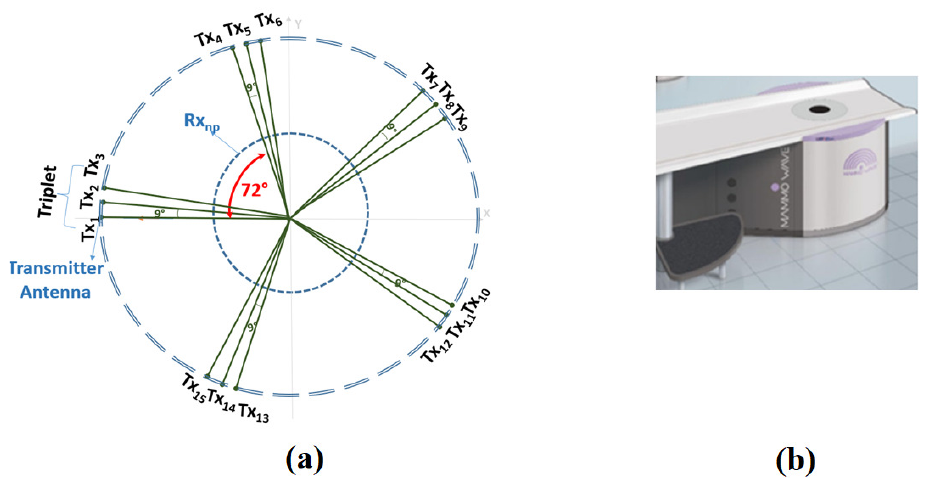
Figure 3. ( a ) Pictorial view of the MammoWave measurements set-up; ( b ) the MammoWave device